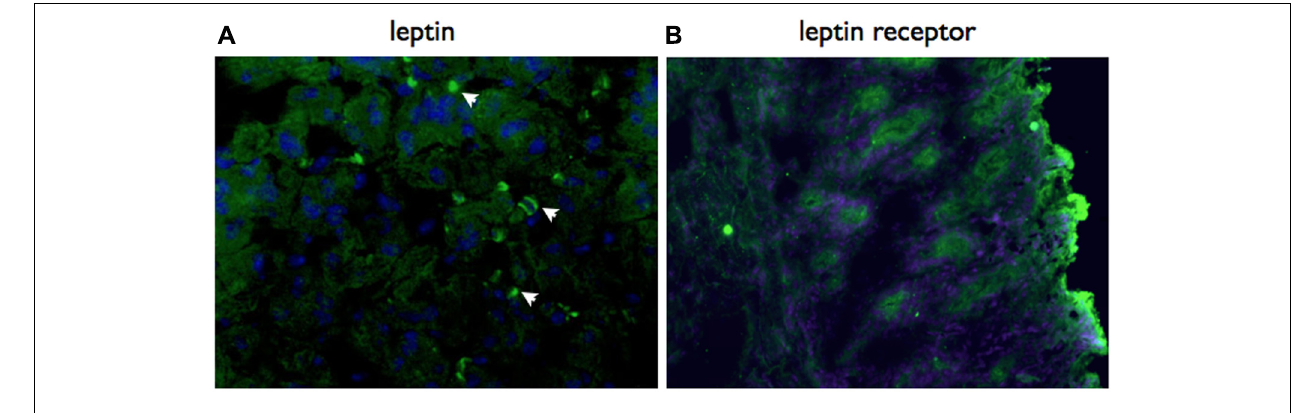
FIGURE 2 | Both leptin and leptin receptor are expressed locally in the gastric mucosa. Immunohistochemistry using specific antibodies, detected with a Cy2 labeled secondary antibody. Both leptin (A) and lepR (B) are expressed in the gastric mucosa of vaccinated mice at